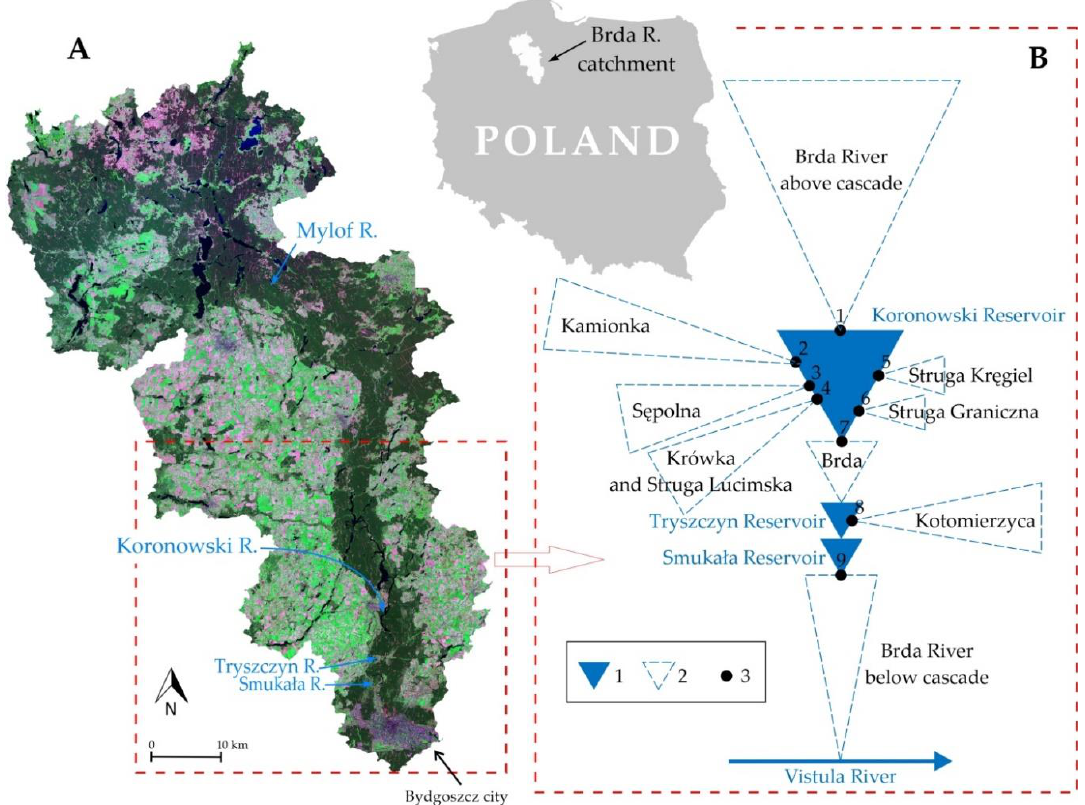
Figure 1. Sketch of the study area: ( A ) analyzed subcatchment on the background of the Brda catchment area, ( B ) diagram of water objects within the studied subcatchment: 1. reservoirs, 2. tributaries subcatchment names, 3. measurement stations (water gauge) of State Environment Monitoring with numbering.